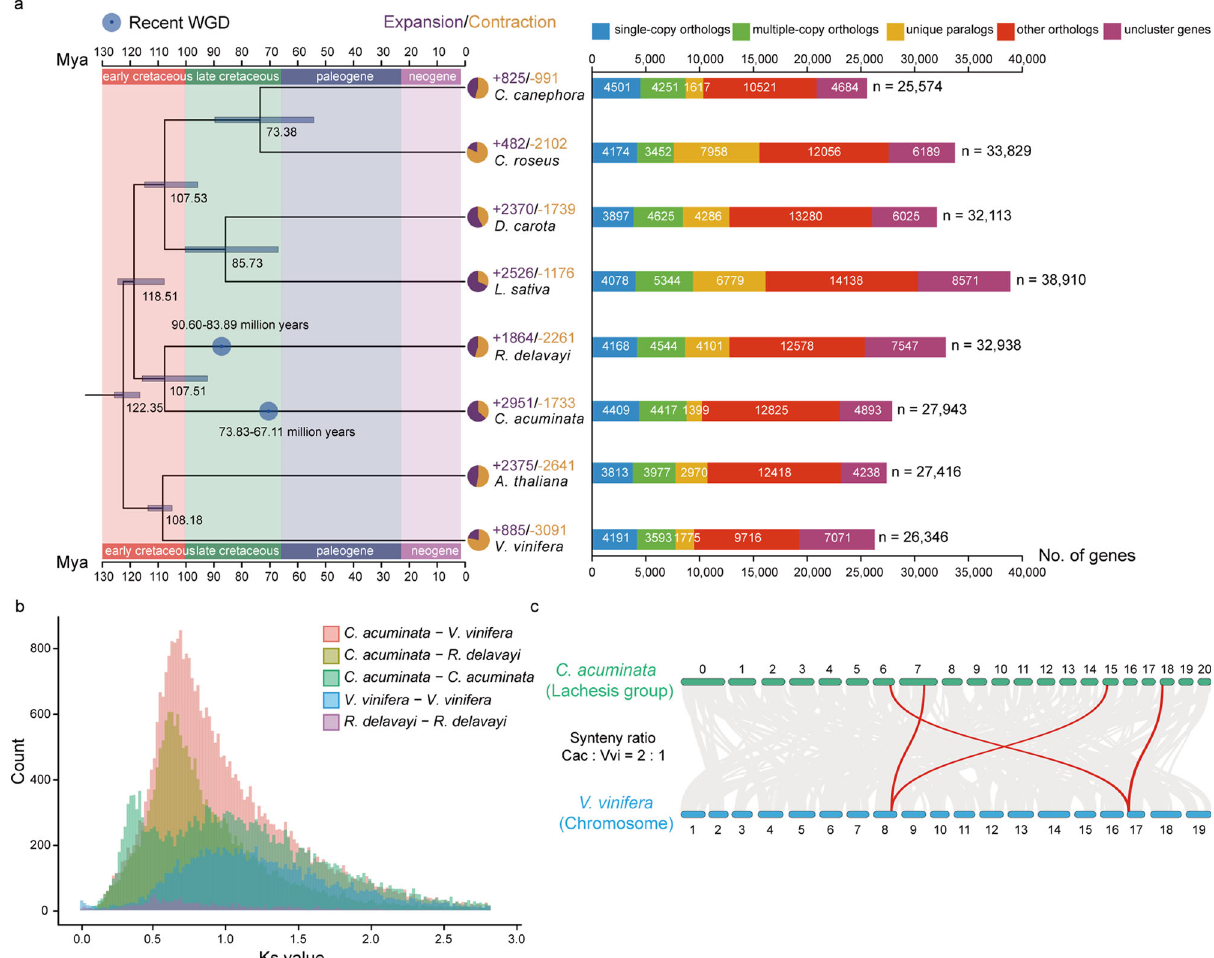
Fig. 1 Phylogenetic analysis of the C. acuminata genome. a Phylogenetic tree for C. acuminata and seven other plants. Genes of C. acuminata and other sequenced genomes are classi fi ed into fi ve classes and the direct numbers ( n ) are shown on the right with bar charts. All branch bootstrap values are 100. Gene family expansions are indicated in purple, and gene family contractions in light-brown; the corresponding proportions among the total changes are shown using the same colors in the pie charts. The estimated divergence time (million years ago, MYA) is indicated at each node; bars are 95% con fi dence intervals (CI) (each center is de fi ned as mean value). Circles in blue represent recent whole-genome duplication (WGD) events. b Ks values revealed a recent WGD event during the evolution of C. acuminata and a WGD event shared by C. acuminata and V. vinifera . c Collinear relationship between C. acuminata and V. vinifera chromosomes. The collinearity pattern shows that typically an ancestral region in the V. vinifera genome can be traced to two regions in C. acuminata . Gray bands in the background indicate syntenic blocks between the genomes spanning more than 15 genes; some of the 1:2 blocks are highlighted in red. Source data underlying Fig. 1a, b are provided as a Source Data fi